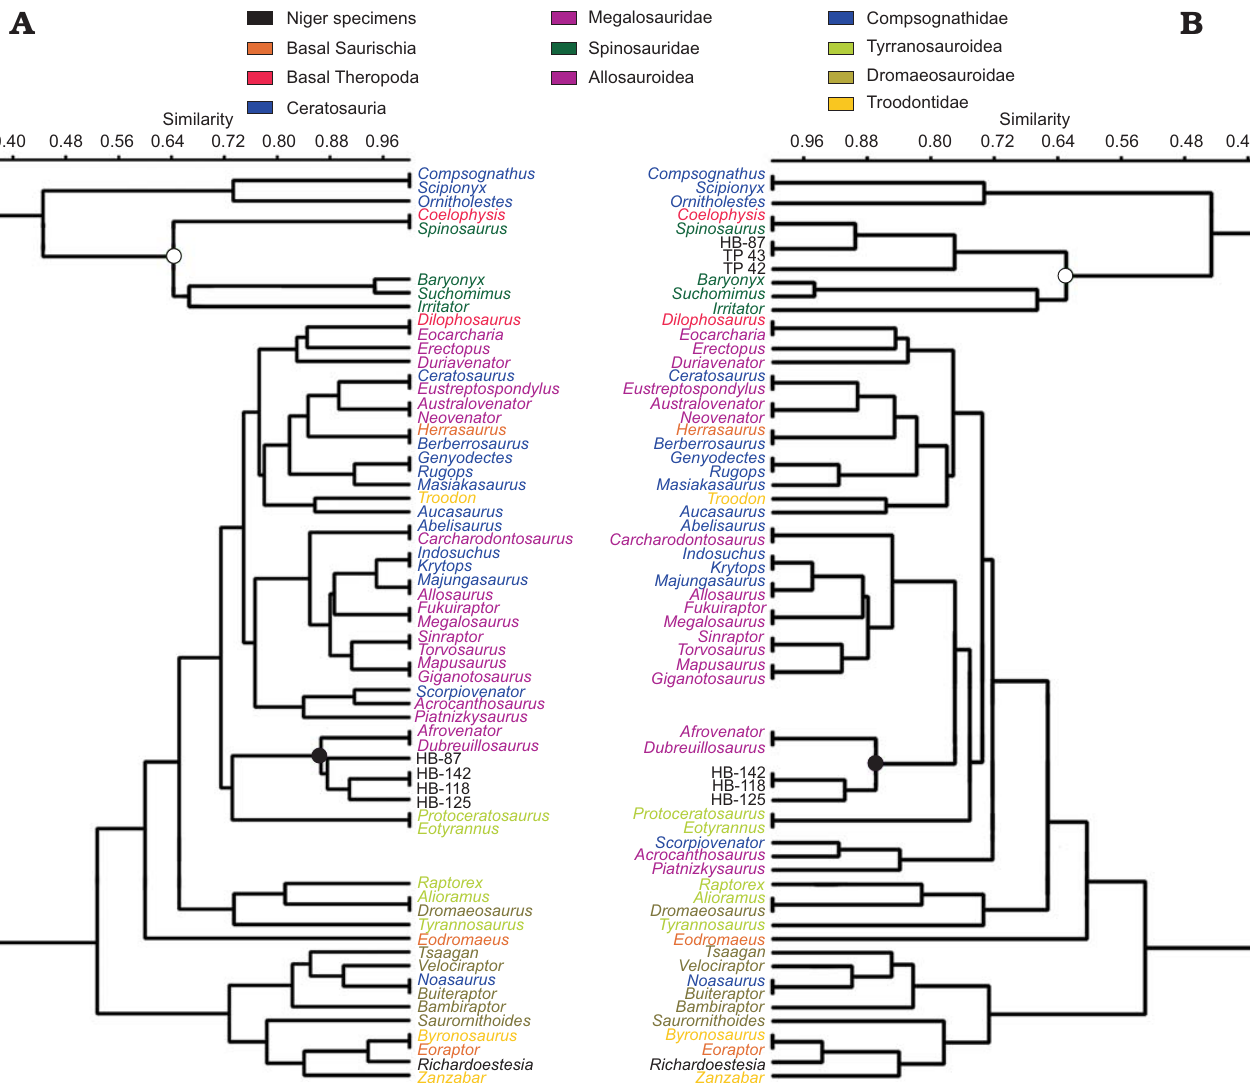
Fig. 4. Dendrogram obtained from the cluster analysis of the theropod teeth. A . Database from Hendrickx and Mateus (2014) and the HB site. The charac- ters used were those proposed by Hendrickx and Mateus (2014) for lateral teeth. HB samples are clustered with Afrovenator and Dubreuillosaurus (black dot). B . Database from Hendrickx and Mateus (2014), the specimens from the HB site, and two basal spinosaurid teeth from the Middle Jurassic TP4 site in Niger (Serrano-Martínez et al. 2015). MUPE HB-118, MUPE HB-125, and MUPE HB-142 remain clustered with Afrovenator and Dubreuillosaurus (black dot), but MUPE HB-87, MUPE TP4-2, and MUPE TP4-3 are clustered with the spinosaurids (white